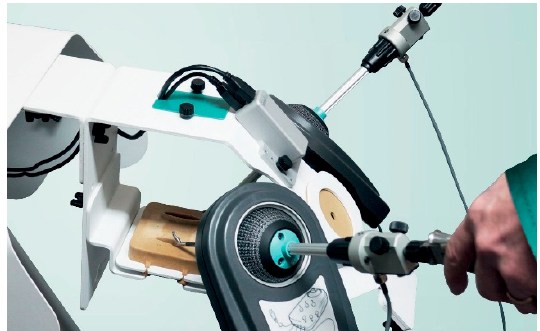
Figure 1. The Simball Box system that was used in the study. The video system can record the operation within the field of view; the Simball can detect motion metrics including instrument speed, acceleration, angular distance, smoothness, and time to the finish task. The laparoscopic instruments were not included in the system and were offered by the users [12].